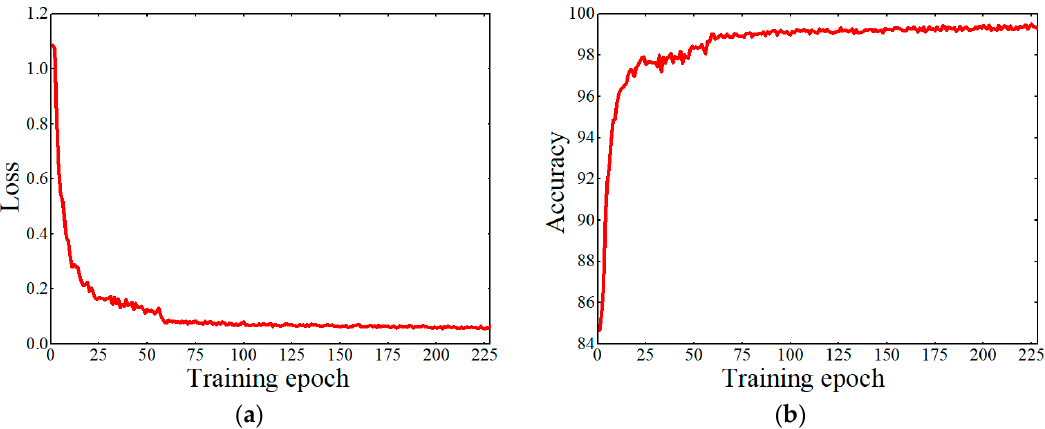
Figure 4. The changes of loss and accuracy values during training process of the grain detection model: ( a ) loss; ( b ) accuracy.